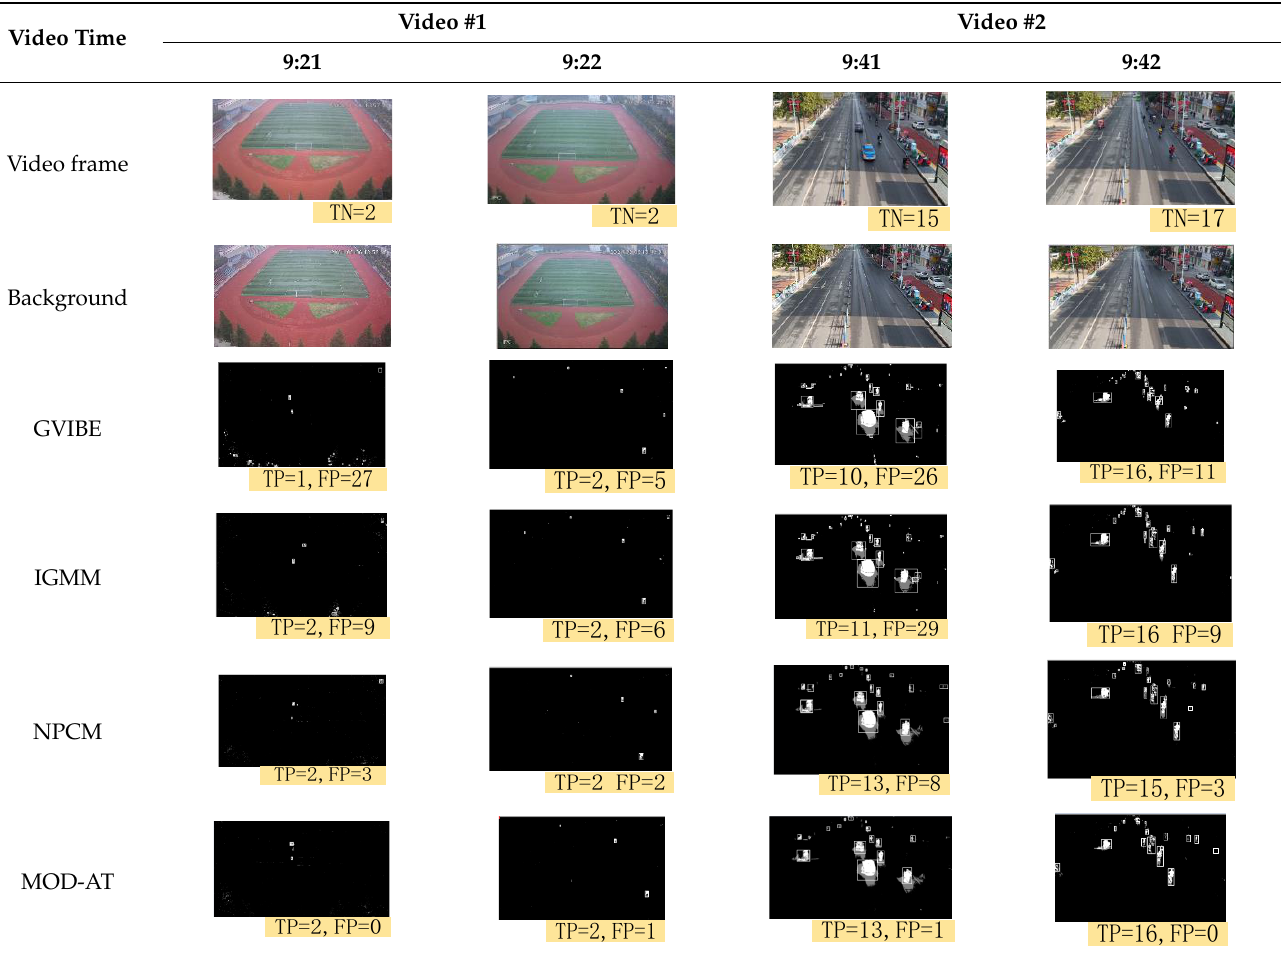
Table 3. Object detection results of videos #1 and #2.